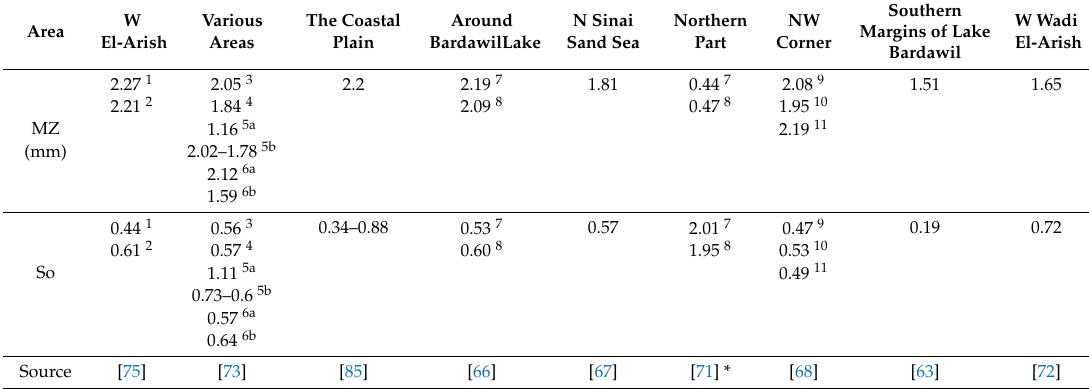
Table 6. Mean grain size and sorting coe ffi cient (So) in some areas of the North Sinai Sand Sea.